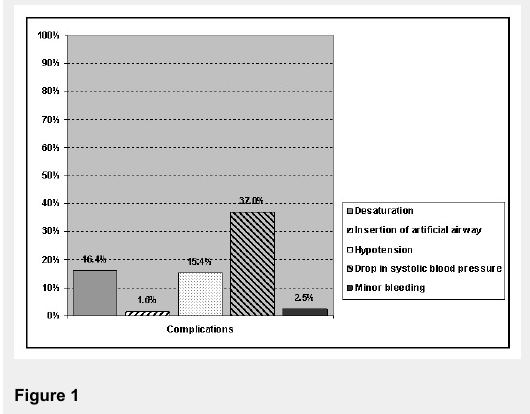
Minor adverse events in 440 patients receiving propofol sedation.